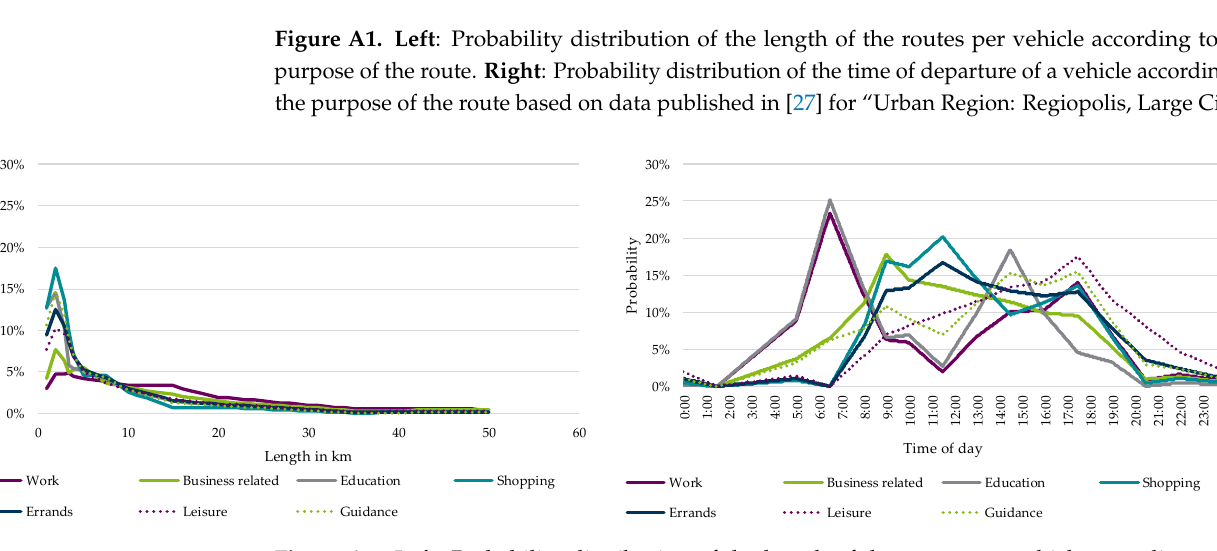
Figure A2. Left : Probability distribution of the length of the routes per vehicle according to the purpose of the route. Right : Probability distribution of the time of departure of a vehicle according to the purpose of the route based on data published in [27] for “Urban Region: Medium-sized City, Urbanised Area”.